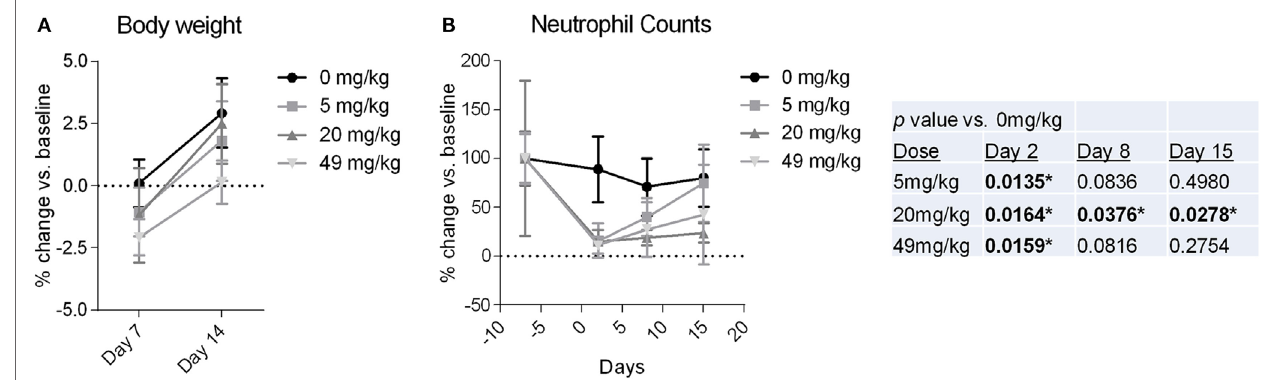
FigUre 6 | Body weight and neutrophil counts from cynomolgus monkeys treated with NEO-201. (a) Percent change in body weight relative to baseline (BL) (day − 1) measured for monkeys at 7 and 14 days after a receiving a single dose of NEO-201 at the indicated dose levels. n = 4 animals per group (two females, two males). (B) Percent change in neutrophil levels relative to BL (day − 7) from the blood of monkeys treated with a single dose of NEO-201 at the indicated dose levels. n = 4 animals per group (two females, two males). *Statistically significant ( p < 0.05) by T